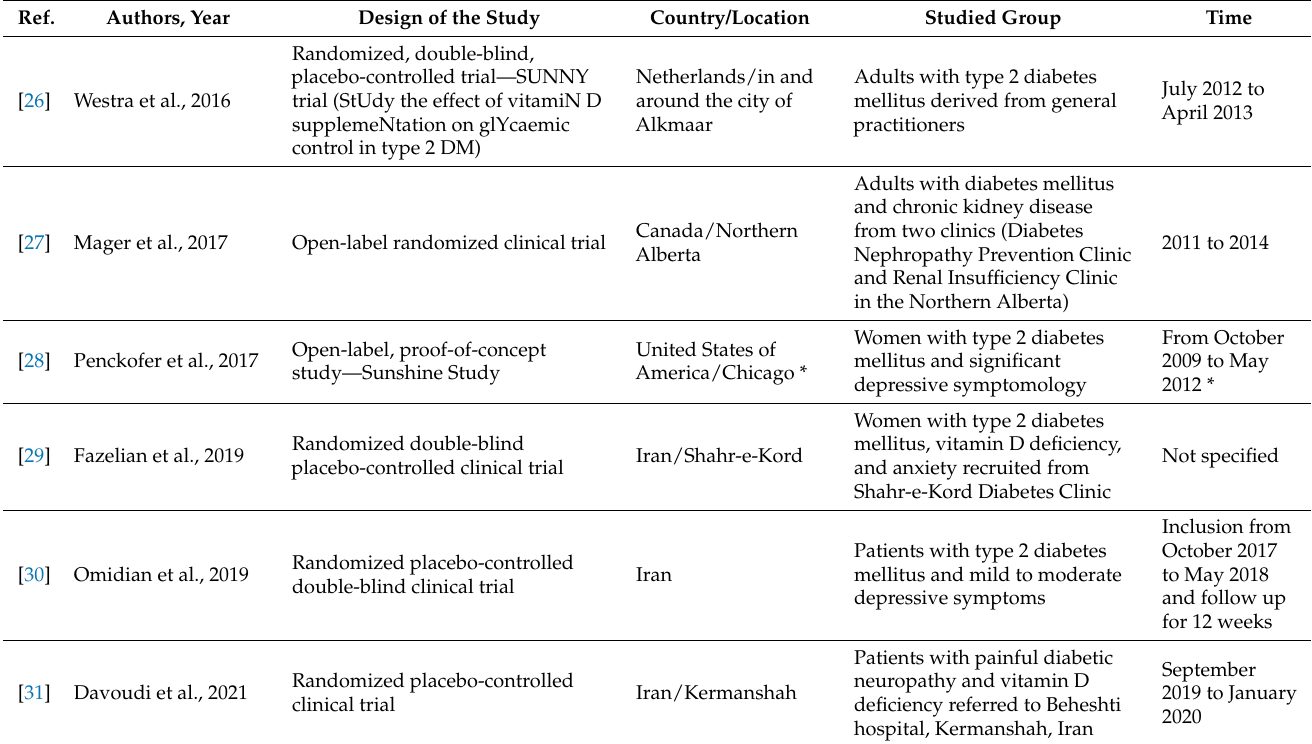
Table 2. The basic details of the studies included to the systematic